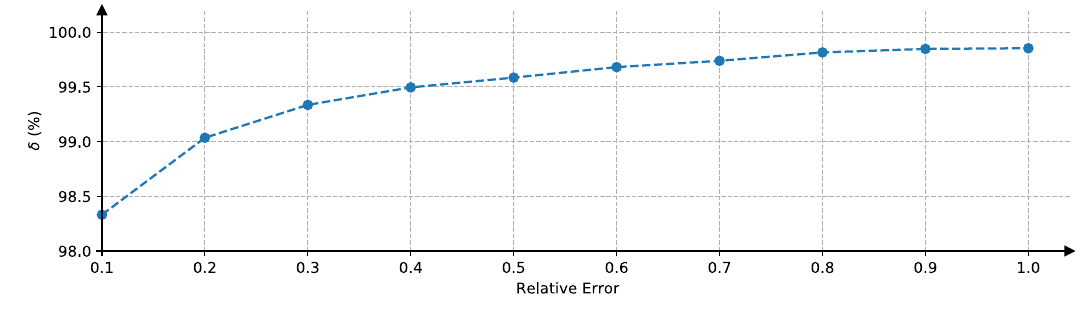
Figure 14. δ corresponding to the threshold of relative error in the test